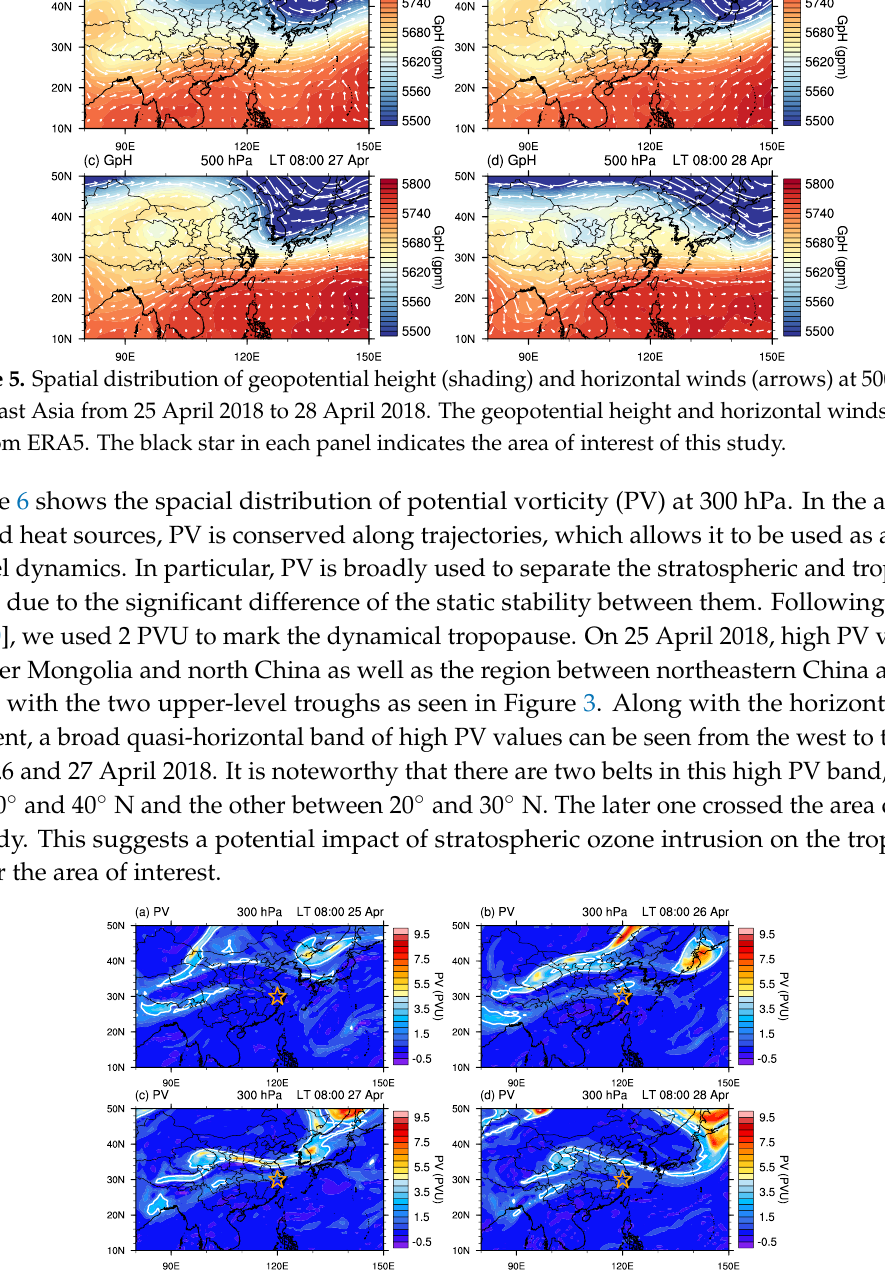
Figure 6. Spatial distribution of potential vorticity (PV) at 300 hPa over east Asia from 25 April 2018 to 28 April 2018. PV is calculated based on ERA5 data. The white contour line indicates the dynamical tropopause of 2 PVU (1 PVU = 10 − 6 m 2 s − 1 K kg − 1 ). The red star in each panel indicates the area of interest in this